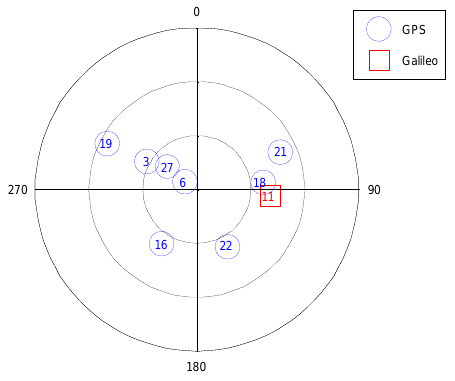
Figure 9. Galileo and GPS sky plot